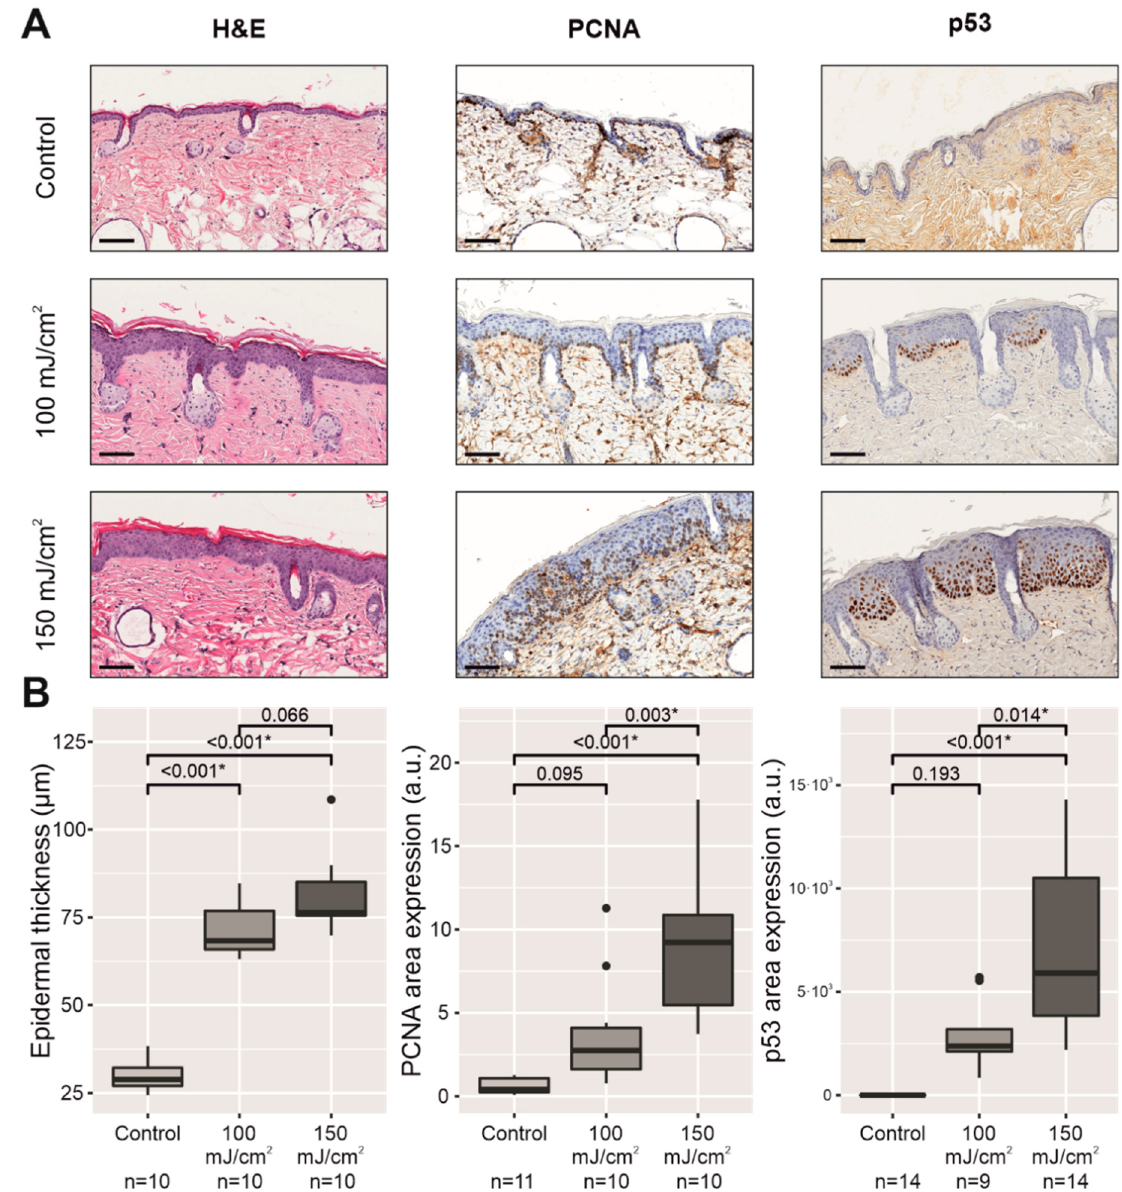
Figure 2. Comparative histology of nonirradiated skin with respect to UV-B-irradiated skin with CFC of the mouse back at the end of the experiment (14 weeks after initiating UV-B irradiation). The scale bar represents 100 µm ( A ). Below the histopathological images, plots represent the epidermal thickness and quantification of PCNA immunostaining and PIPs using ImageJ software and are expressed in arbitrary units (a.u.) ( B ). * p < 0.05.